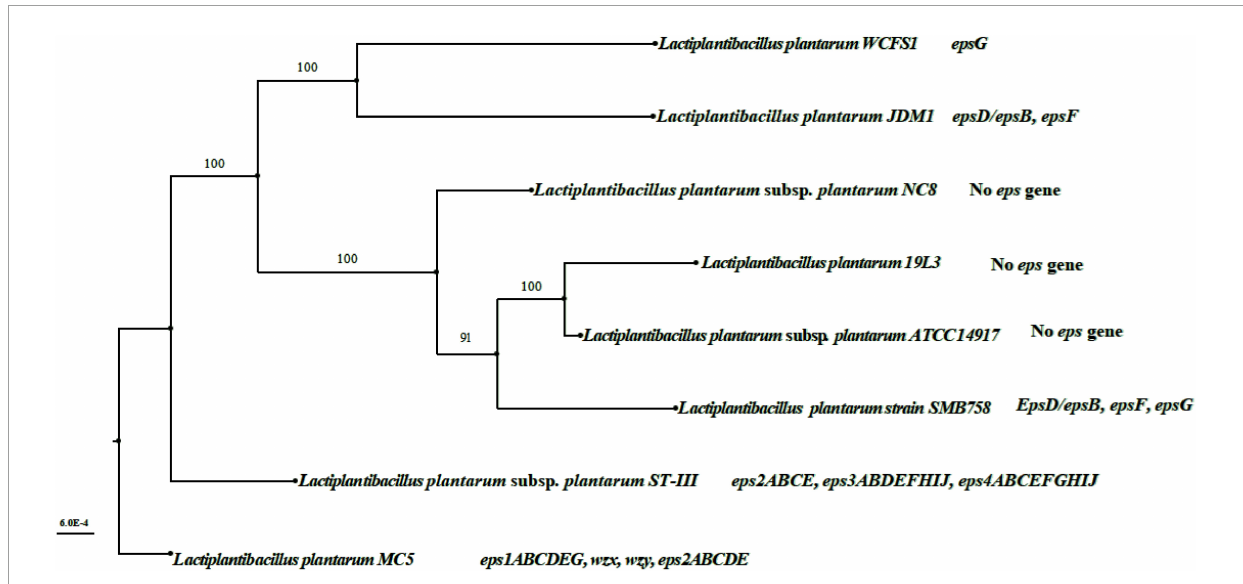
FIGURE6 Whole-genome phylogenetic tree of Lp. plantarum strains with different eps genes. The whole genome sequence of the 7 strains of LAB in Figure 6 was downloaded from the NCBI database, and the GenBank ID of these 7 strains were shown in Table 1 . Mega 6.4 (Mega Limited, Auckland, New Zealand) software done their whole genome phylogenetic tree.